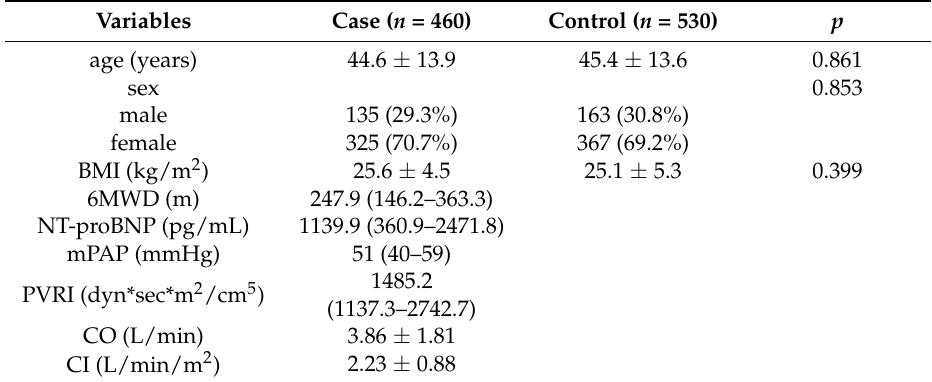
Demographic and hemodynamic characteristics of PAH patients (case) and normal subjects